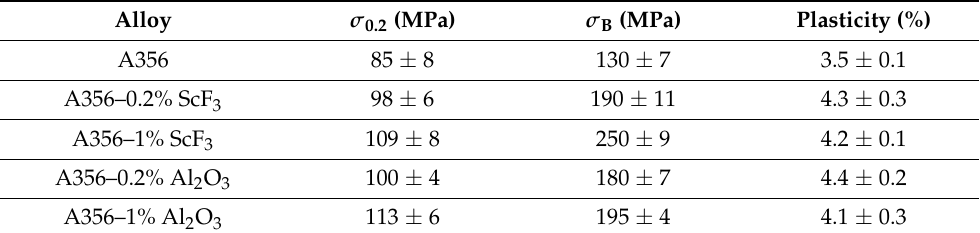
Table 1. Mechanical properties of aluminum alloys.